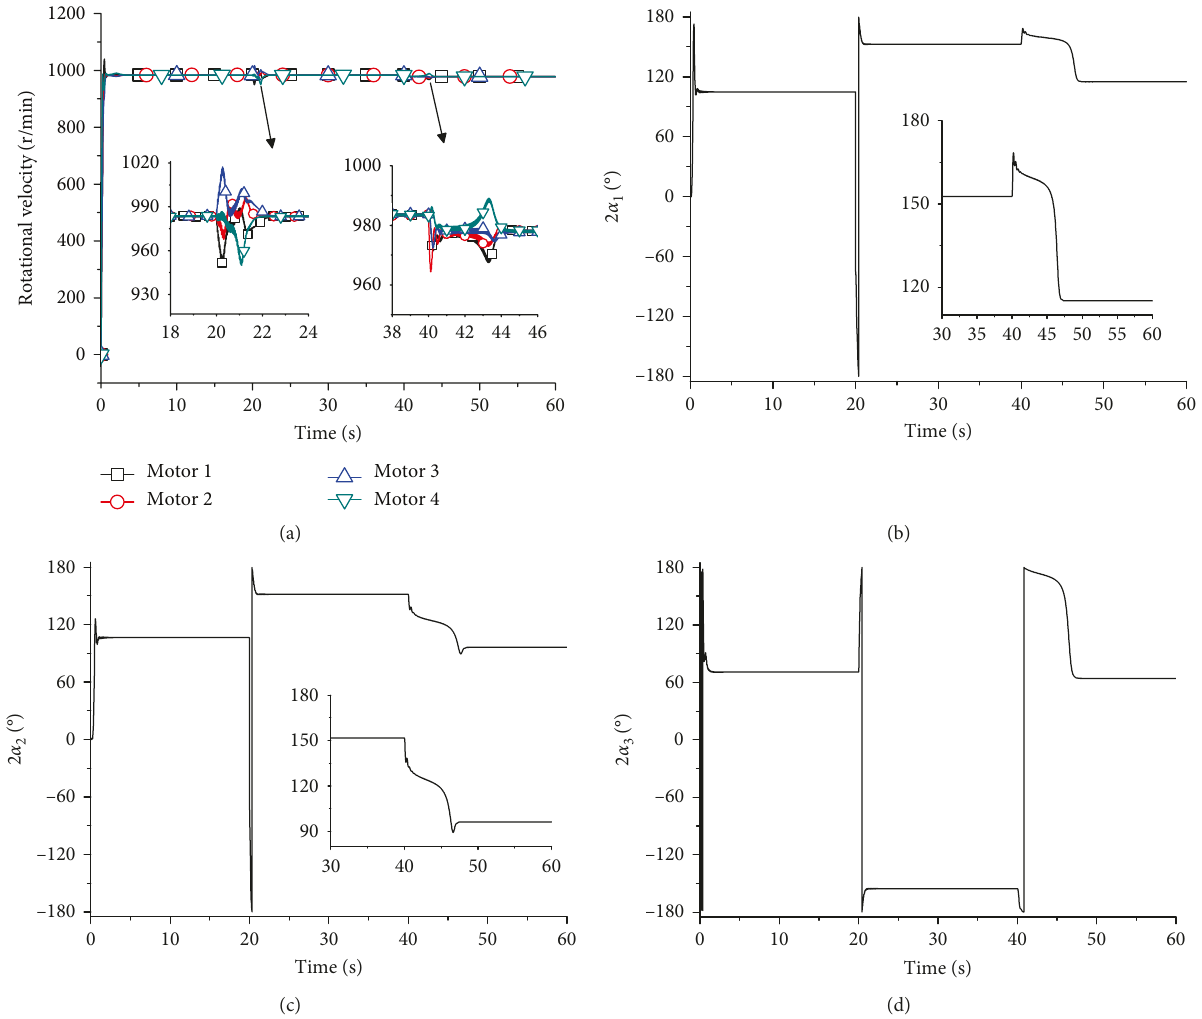
, η . 5. (a) Rotational velocities of the four motors; (b) phase difference 1 (cid:31) η 2 (cid:31) η 3 (cid:31) 1 4 (cid:31) 0